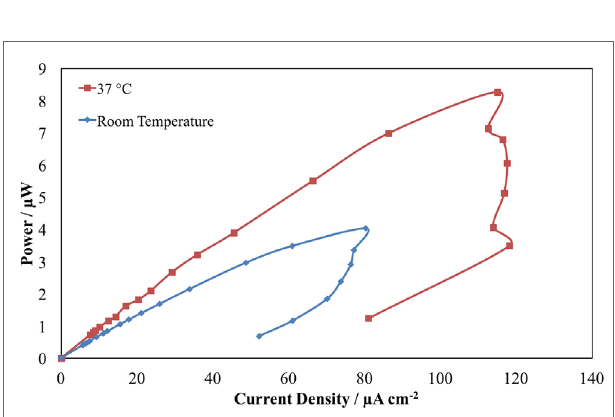
FigUre 5 | The power output of the fuel cell operating in human serum and different glucose additions, at room temperature .